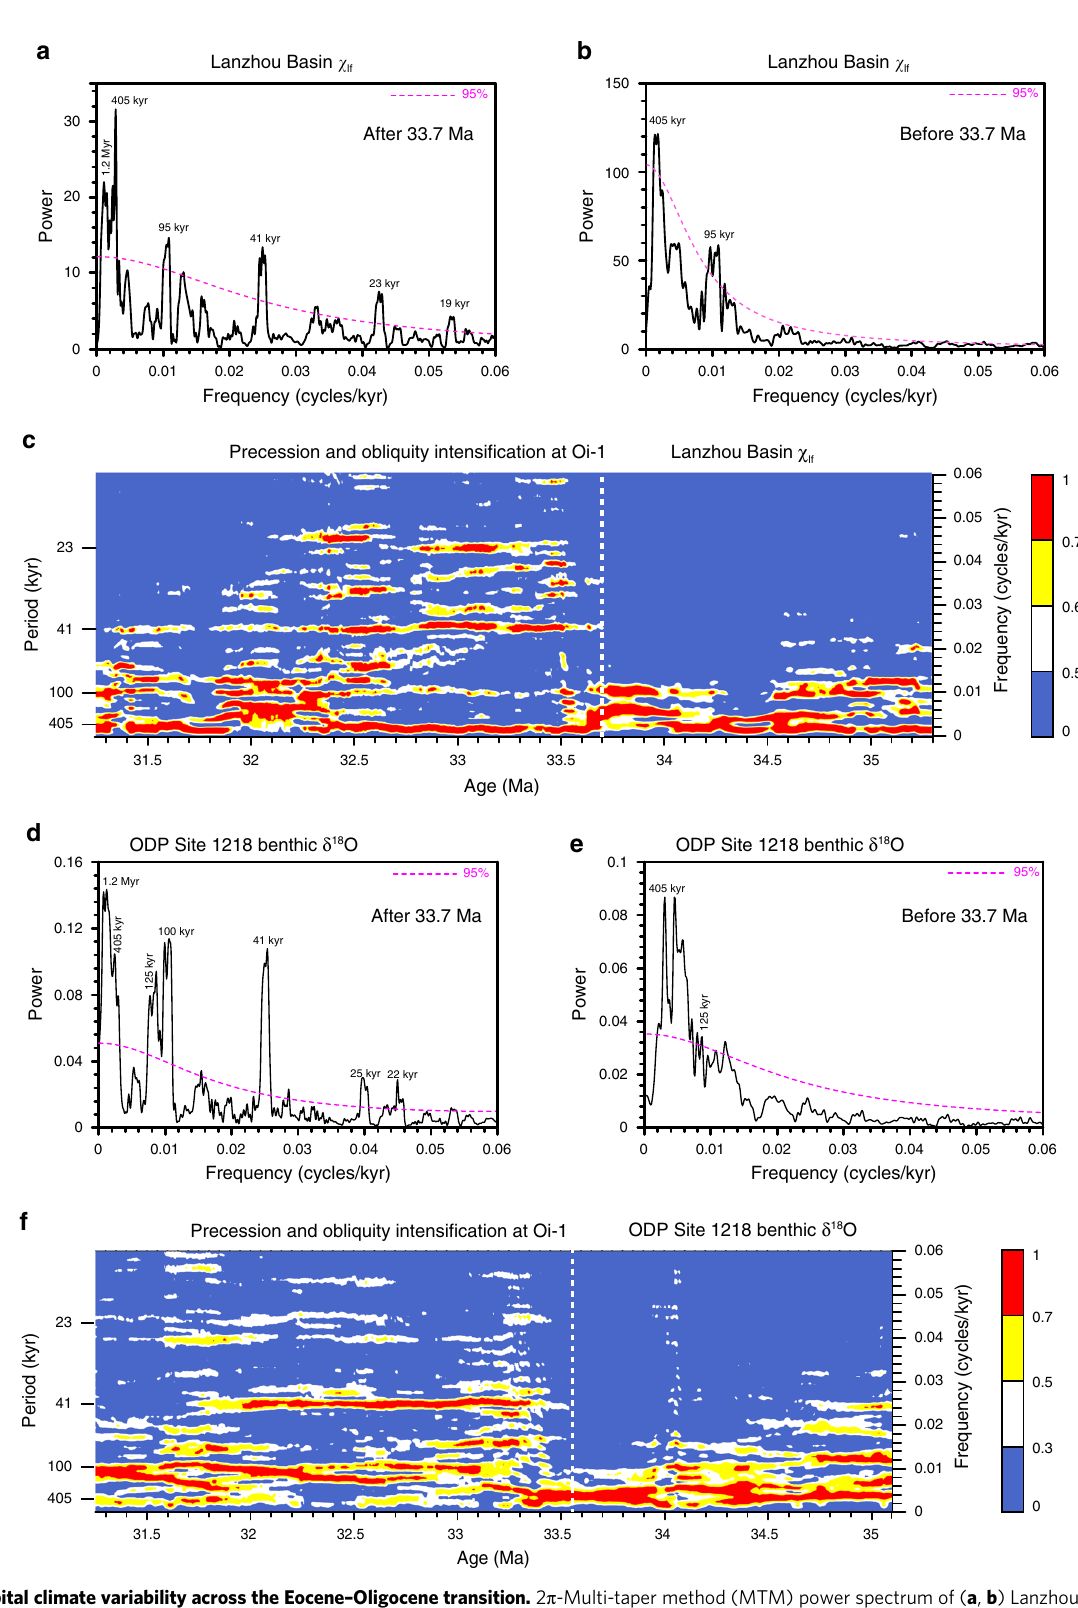
Fig. 4 Orbital climate variability across the Eocene – Oligocene transition. 2 π -Multi-taper method (MTM) power spectrum of ( a , b ) Lanzhou Basin χ lf and ( d , e ) ODP Site 1218 benthic δ 18 O records after and before 33.7 Ma, with a robust red-noise model at the 95% con fi dence level. Spectral evolution for ( c ) Lanzhou Basin χ lf and ( f ) ODP Site 1218 benthic δ 18 O records calculated using the MATLAB Evoffte routine, with a 600-kyr sliding window and 2-kyr sliding